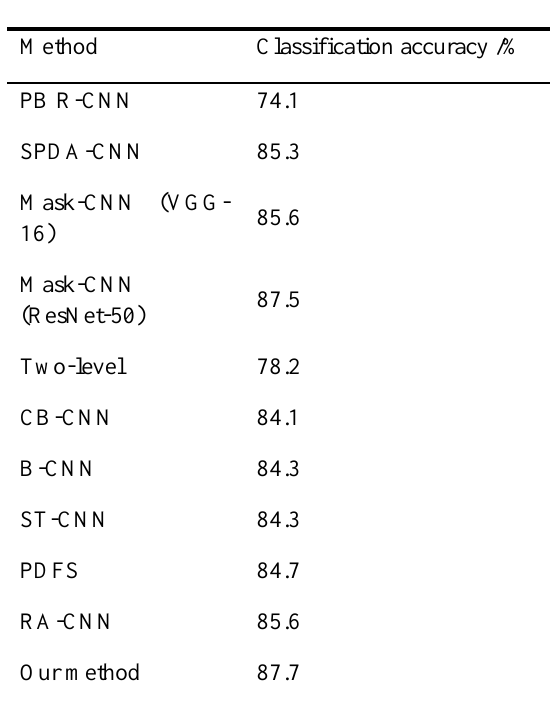
Table 1. Classification accuracy of different methods on CUB-200-2011